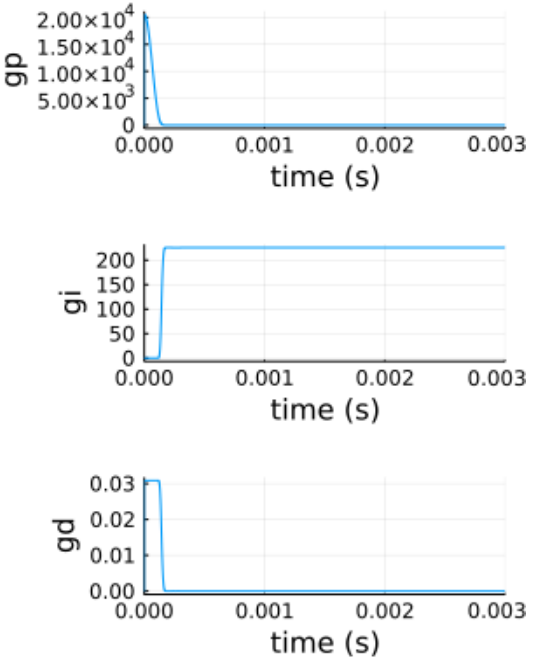
Figure 8. Variation of the adaptive gains of the controller (obtained by ABC optimization) during the initial transition.